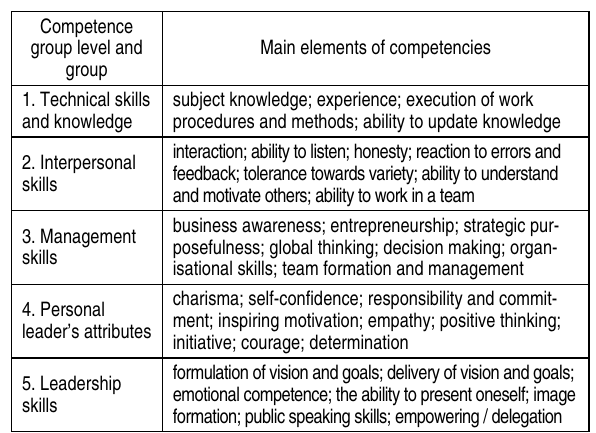
Table 1. The leadership competence in the general competence